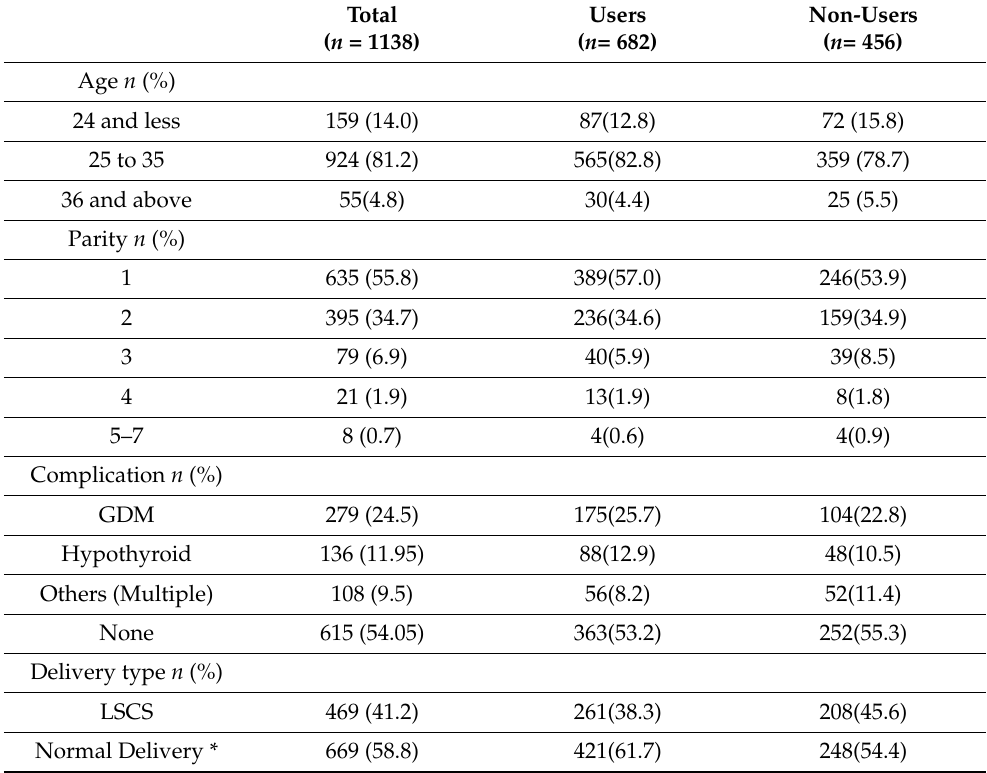
Table 1. Characteristics of the study participants.